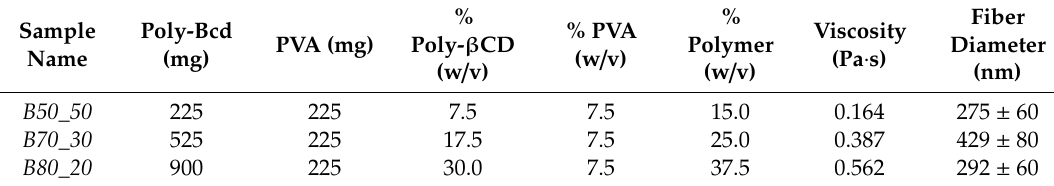
Table 1. Properties of poly( β -cyclodextrin) (Poly- β CD) / poly(vinyl alcohol) (PVA) solutions and average diameters of the corresponding